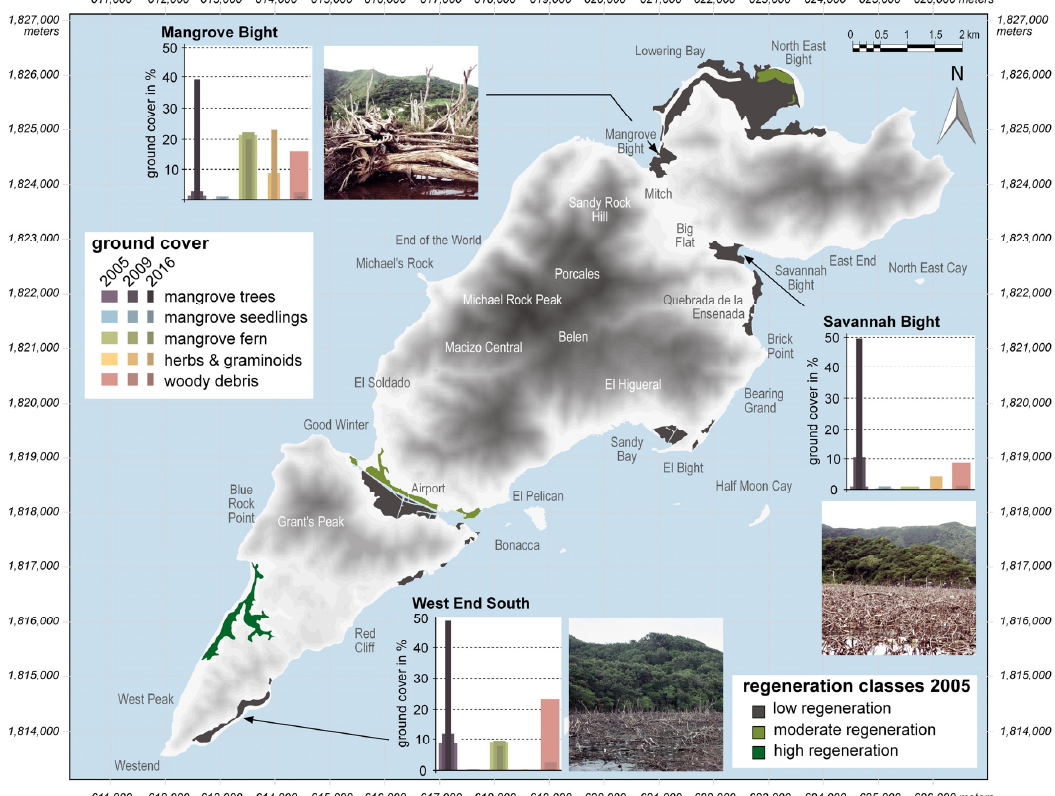
Figure 2. Shaded relief of Guanaja (SRTM data) with the categorization of mangrove regeneration in 2005; bar plots visualize the development of mean ground cover of certain functional groups at MB, SB, and WES during the study period; photographs illustrate the degree of disturbance seven years after Hurricane Mitch (adapted and modified from [37]).